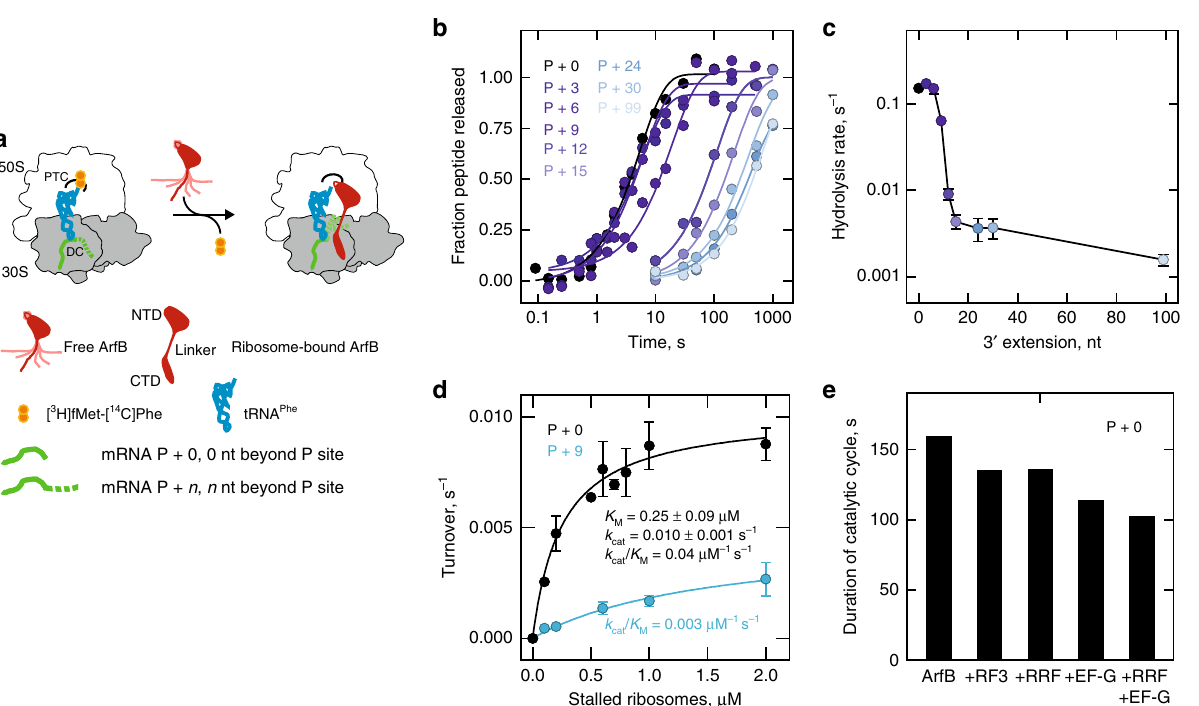
Fig. 1 ArfB preferentially rescues ribosomes stalled on short mRNA. a Experimental assay for ArfB-mediated ribosome rescue. Ribosome complexes with mRNAs of different length are rapidly mixed with ArfB and the fraction of peptides released from tRNA by ArfB-dependent hydrolysis is quanti fi ed. PTC peptidyl transferase center; DC decoding center; NTD N-terminal domain; CTD C-terminal domain. Free ArfB is shown as an ensemble of dynamic molecules 10 , the ribosome-bound ArfB is shown as in the X-ray structure 15 . b Time courses of single-round peptidyl-tRNA hydrolysis at excess ArfB (1 µ M) over ribosome complexes (0.15 µ M). The mRNA length is indicated by number of nucleotides (nt) extending beyond the P site, from none (P + 0) to 99 nt (P + 99). Data represented as mean values of two biological replicates. Solid lines are exponential fi ts. c Rate of hydrolysis at increasing mRNA length. Error bars indicate the SEM of the exponential fi ts ( b ). d Peptidyl-tRNA hydrolysis on P + 0 and P + 9 complexes at limiting ArfB concentrations. Initial velocity of the hydrolysis reaction is measured after mixing ArfB (0.02 µ M) with increasing concentrations of P + 0 or P + 9 complexes. Solid lines are results of hyperbolic fi tting. Error bars represent the SEM of three biological replicates. e Effect of ribosome recycling factors on the duration of an ArfB catalytic cycle on P + 0 complexes (0.2 µ M) mixed with catalytic amounts of ArfB (0.02 µ M) and excess of RF3 (0.5 µ M), RRF (0.5 µ M) and EF-G (0.5 µ M). All experiments were carried out at 37 °C.